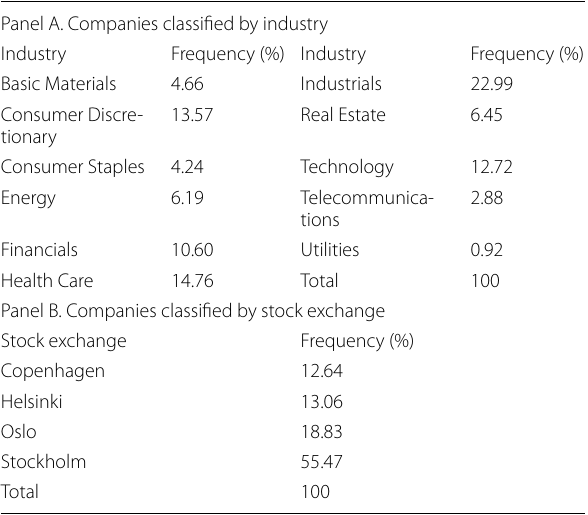
Table 1 Frequency distribution of companies across industries